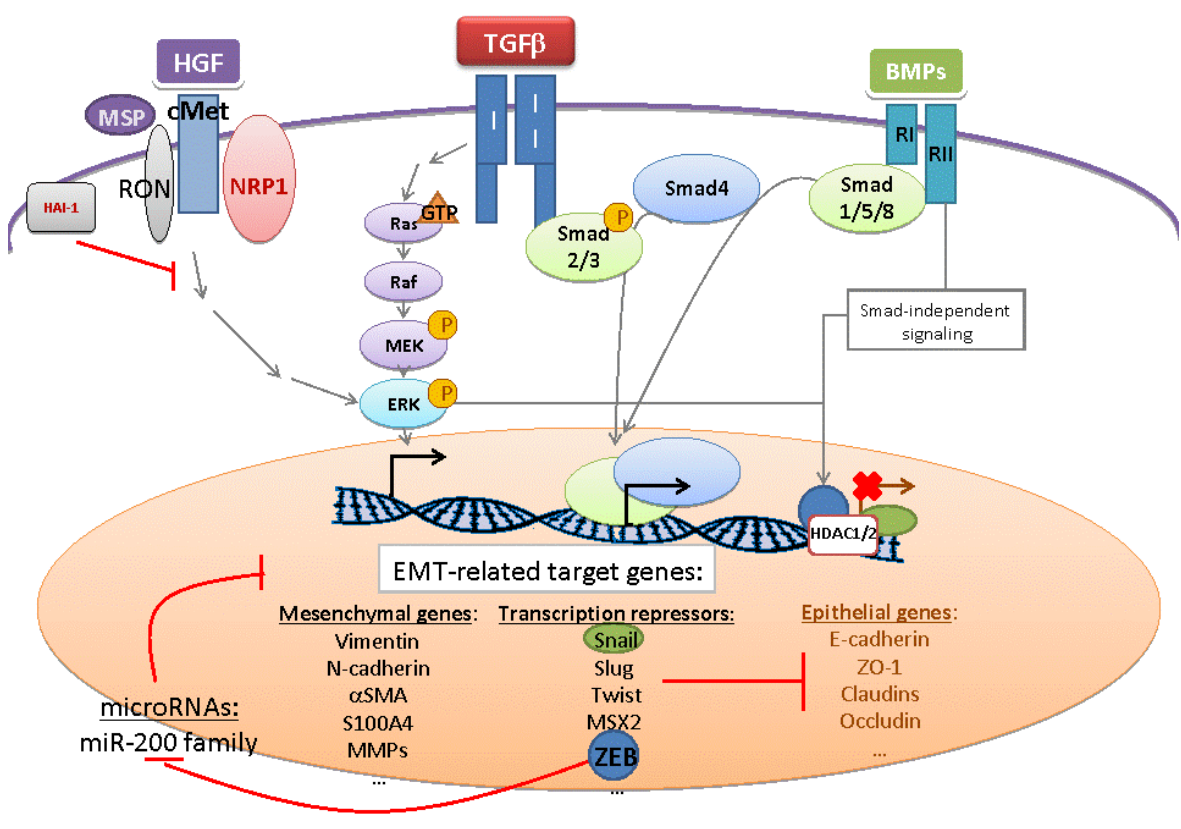
FIGURE 1. Growth factor–induced EMT signaling pathways in pancreatic cancer. TGFβ, hepatocyte growth factor (HGF), and bone morphogenic proteins (BMP) 2, 4, and 7 through binding of their receptors (TGFRI/RII, c-Met, and BMPRI/RII, respectively) trigger the activation of the expression of EMT-related genes, including mesenchymal genes and transcription repressors that, in turn, down-regulate the expression of epithelial genes in collaboration with histone deacetylases (HDAC)1/2. Transcription activation can be both Smads-dependent and - independent, through the activation of the Ras/ERK